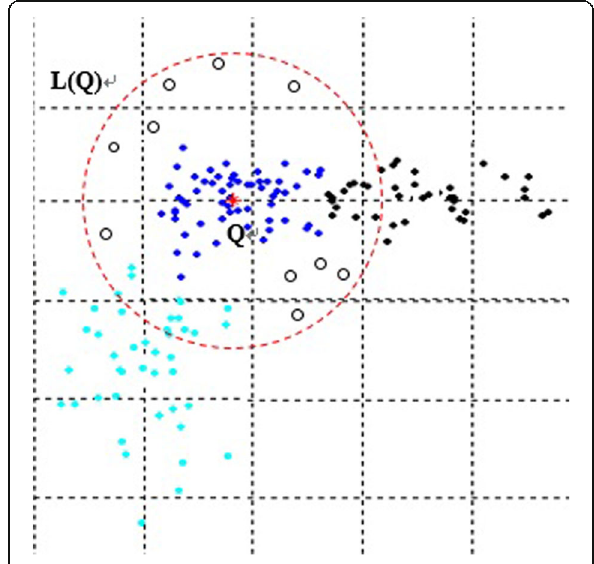
Fig. 3 Distribution of user retrieval targets